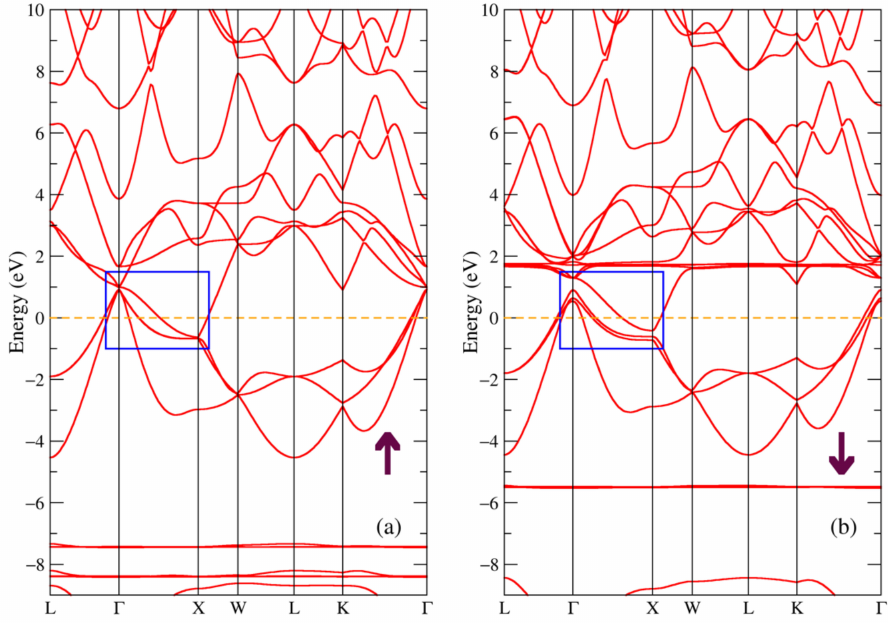
Figure 10. Band structure of HoSb: ( a ) majority and ( b ) minority spin